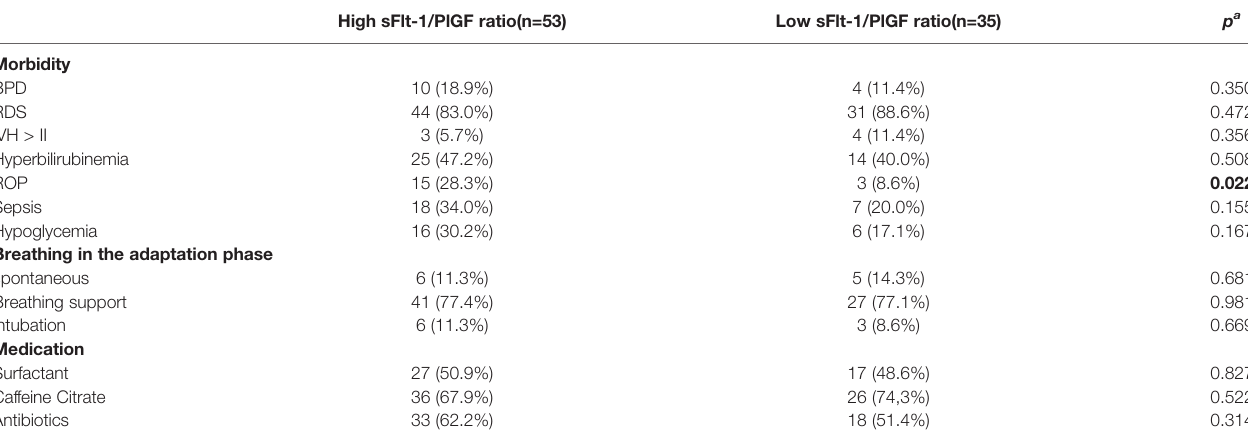
TABLE 4 | Perinatal outcome.